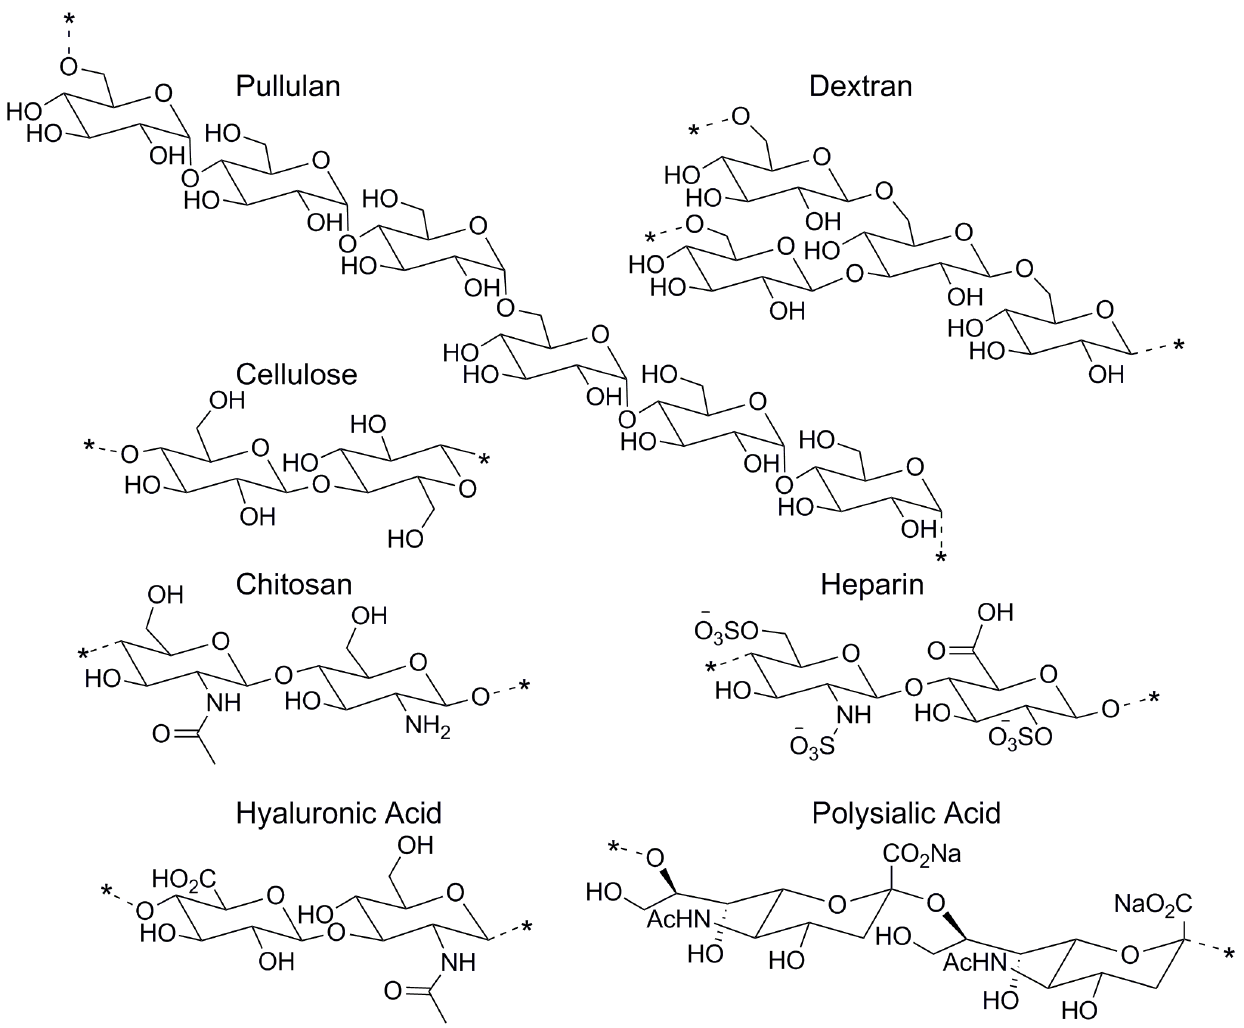
Figure 1. Structures of polysaccharides that are used in the development of micelle drug delivery